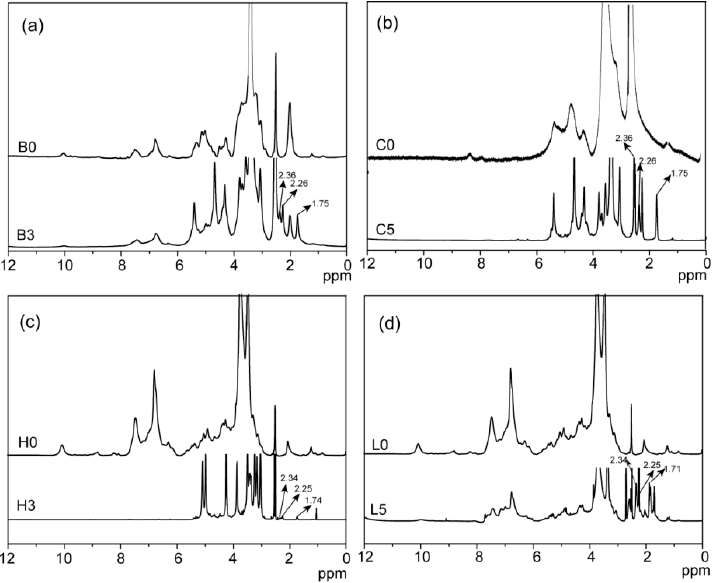
Figure 2. 1 H NMR spectra of bagasse ( a ); cellulose ( b ); hemicelluloses ( c ) and lignin ( d ) samples.